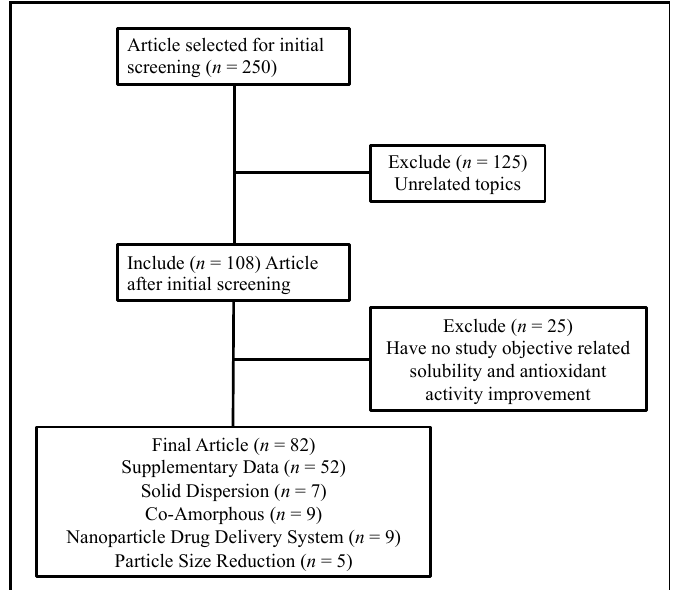
Figure 1. Flow chart of the methodology.